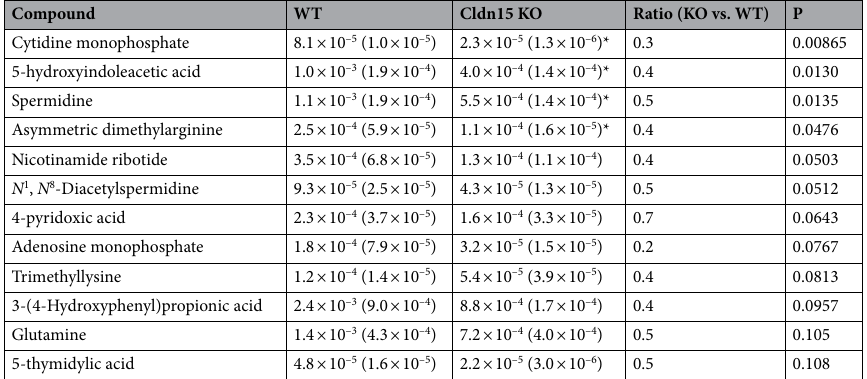
Table 2. Compounds found to be lower in the cecal luminal contents of Cldn15 KO mice. Data are expressed as the mean (SD) relative area of the peak for each metabolite for WT (n = 3) and Cldn15 KO (n = 3). The relative ratio compares the mean KO value vs the mean WT value. Welch’s T-test was used to compare the means, P < 0.05 was considered to be significantly different.